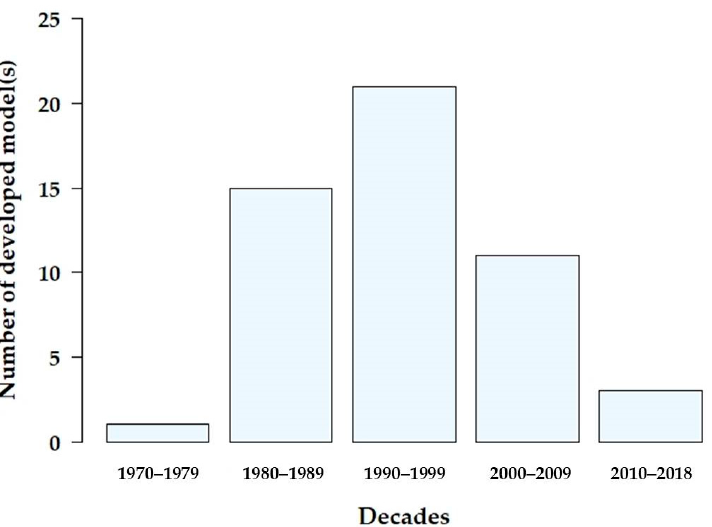
Figure 1. Number of process-based soil erosion models developed over the decades between 1970 and 2018 based on Aksoy and Kavvas [22] (p. 253), Hajigholizadeh et al. [23] (pp. 11–13), Karydas et al. [24] (p. 10), Merritt et al. [25] (pp. 766, 791) and Pandey et al. [21] (pp. 600–606). The number of